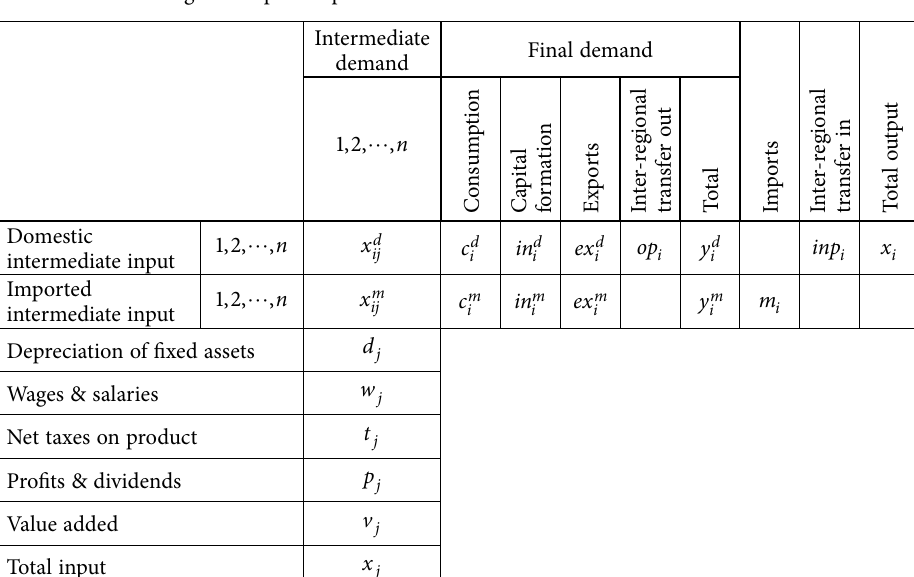
Table 2. Extended regional input-output